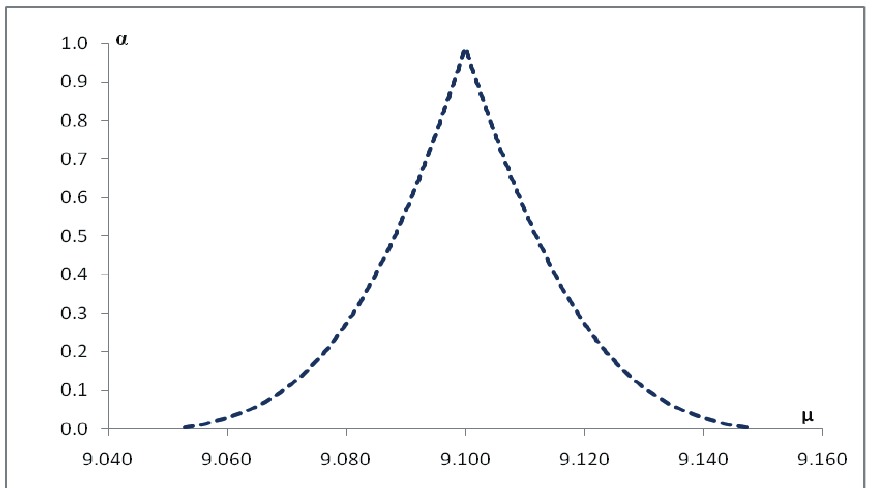
Figure 1 Membership function of process mean for Supplier-A